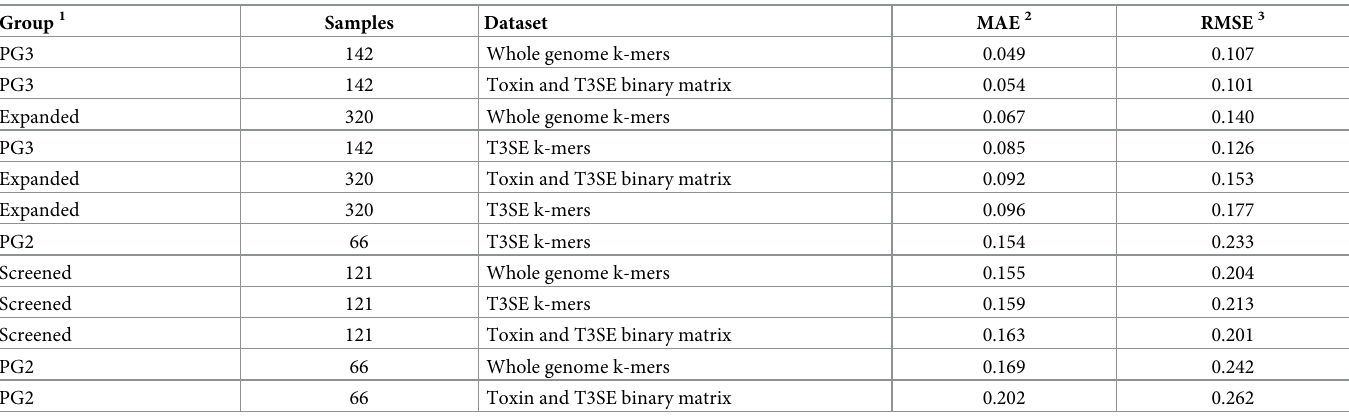
Table 2. Machine Learning Model Performance Sorted by Decreasing